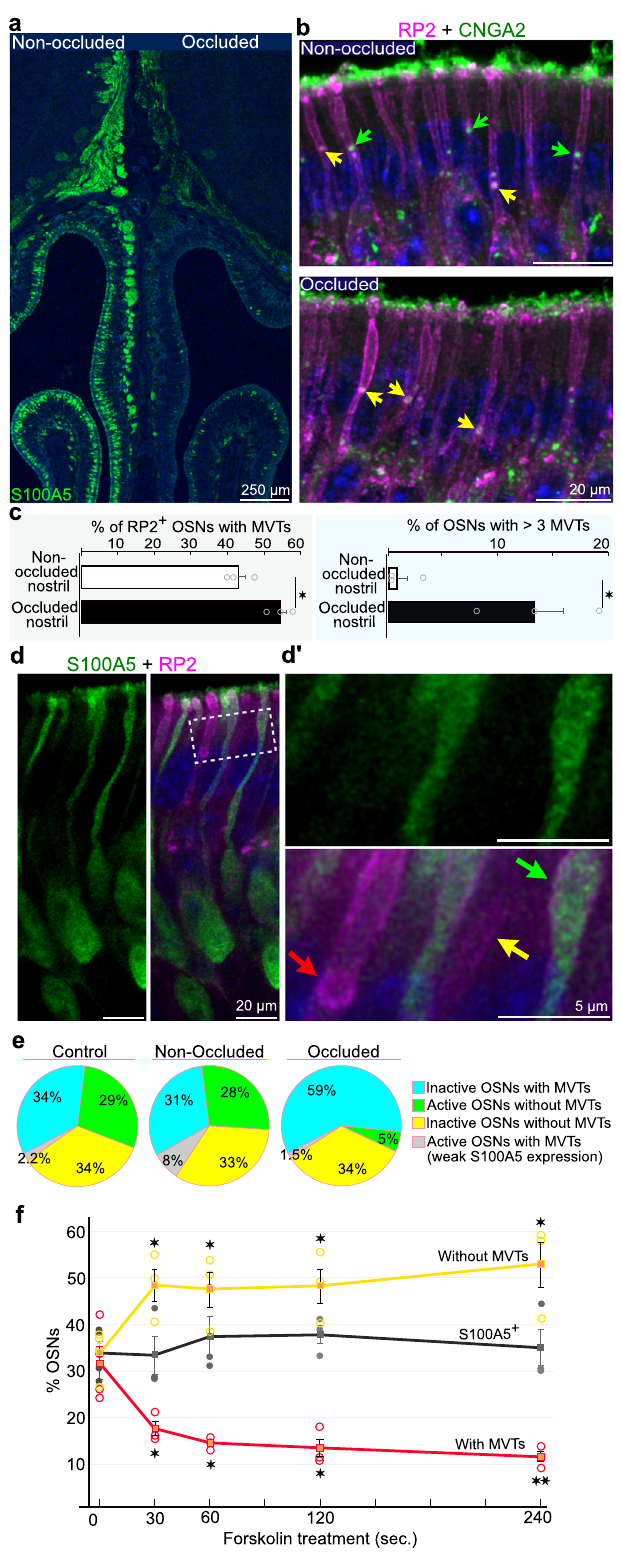
Fig. 7 | Disintegration of the RP2 + -limiting membrane is inhibited by naris occlusion and stimulated by the AC3 activator forskolin. a S100A5 immuno- histochemistry in OSN cell bodies and axons after unilateral naris occlusion is shown. The expression level of S100A5 (green) was reduced in OSNs located ipsi- lateraltotheoccludednaris(occluded)comparedtoOSNslocatedcontralateralto the occluded naris (non-occluded). b , Double immunohistochemistry for RP2 (magenta)andCNGA2(green)inOSNsintheOEofthenon-occludedandoccluded naris. MVTs (RP2 + /CNGA2 + puncta) and ILVs* (RP2 - /CNGA2 + puncta) are indicated byyellowandgreenarrows,respectively. c ,Thebargraphsshowthepercentageof OSNs with MVTs and the percentage of OSNs with > 3 MVTs in OE on the non- occluded and occluded side. Sample sizes were 509 and 539 OSNs for non- occluded and occluded nasal cavity, respectively. Two-sided unpaired Student ’ s t - testgave p =0.020(left)and p =0.020(right)( n =3micepercondition).Thevalues representthemean±SEM. d DoubleimmunohistochemistryforRP2(magenta)and S100A5 (green). d´ Close-up of the area outlined in d. the red and yellow arrows indicateinactive(S100A5 − )OSNswithandwithoutanMVT,respectively.Thegreen arrowindicatesanactive(S100A5 + )OSNwithoutanMVT. e Piegraphsshowingthe percentages of active/inactive OSNs with/without MVTs in OE of control (unoper- ated)miceandonthenon-occludedandoccludedsideofunilateralnarisoccluded mice. Sample sizes were 630, 338 and 441 OSNs for control, non-occluded and occluded nasal cavities, respectively (3 mice per condition). f Graph showing the change in the number of inactive (S100A5 - ) OSNs with (red curve) and without (yellow curve) MVTs seconds after administration of forskolin to the OE ex vivo. The black curve indicates the number of S100A5 + OSNs. Sample sizes at 0, 30, 60, 120 and 240s were; 1289 OSNs (4 mice), 957 OSNs (3 mice), 1095 OSNs (3 mice), 1164 OSNs (3 mice) and 1315 OSNs (3 mice), respectively. The values represent the mean±SEM. Two-sided unpaired Student ’ s t -test of data for 0s compared to each ofthetimepointindicatedintheplot(notadjustedformultiplecomparisons),gave thefollowingpvaluesfromlefttoright:0.026,0.039,0.029,0.021(curveinyellow) and 0.039, 0.017, 0.017, 0.009 (curve in red). * p <0.05, ** p